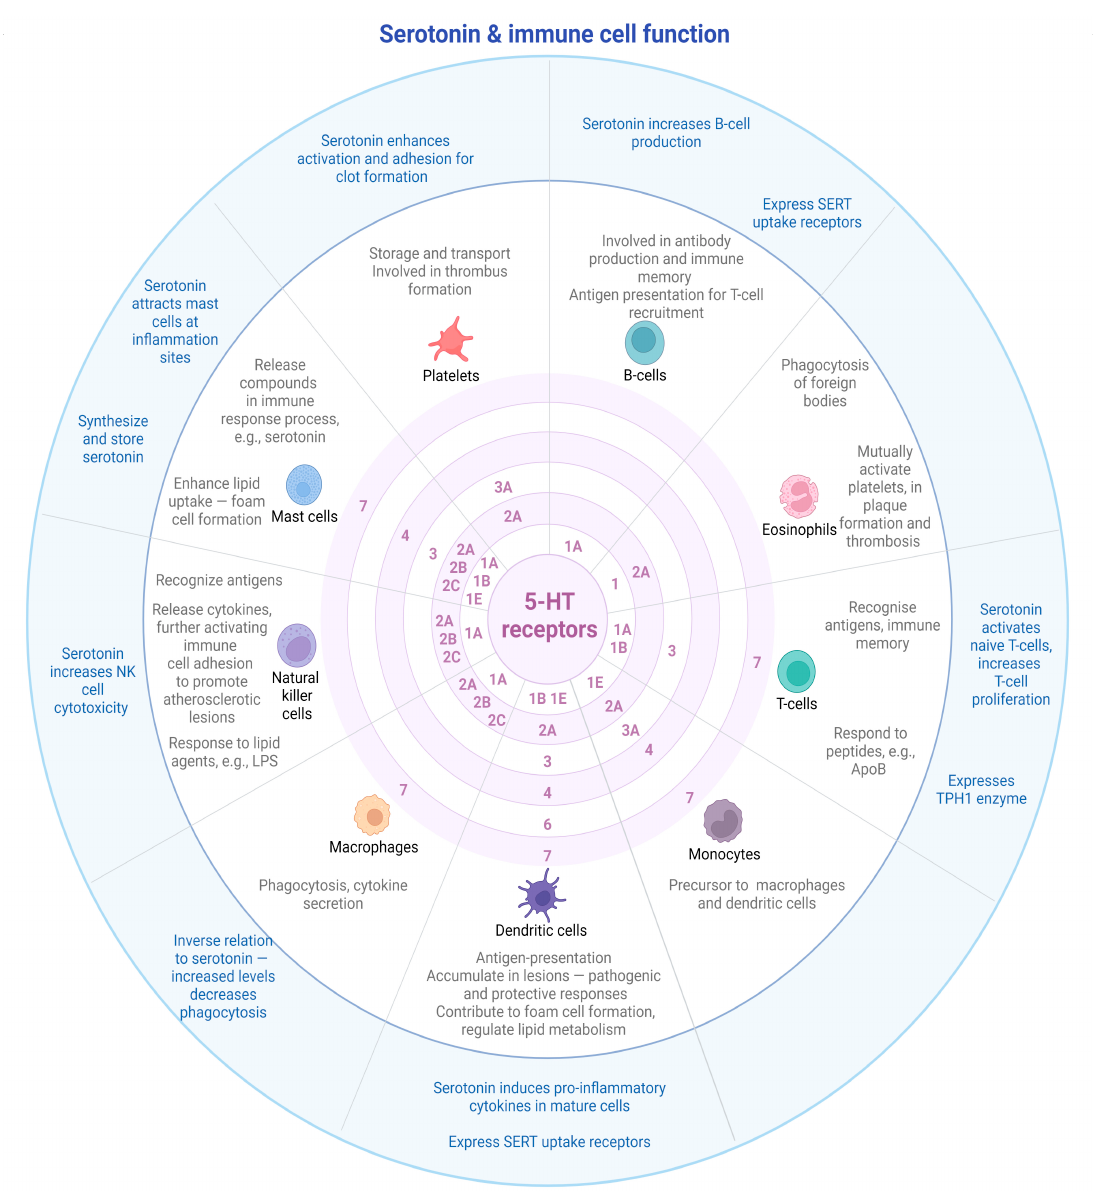
Figure 4. Expression of 5-HT receptor groups and subtypes on immune cells, and effects of serotonin on cellular function. Original references for the receptors as summarized in this figure are detailed